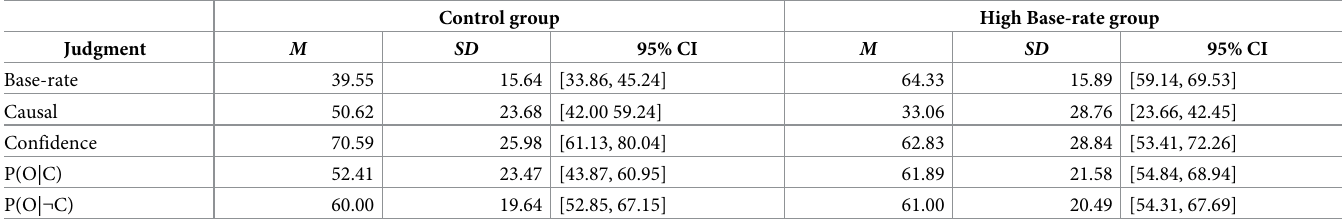
Table 1. Descriptive statistics of the five judgments collected in Experiment